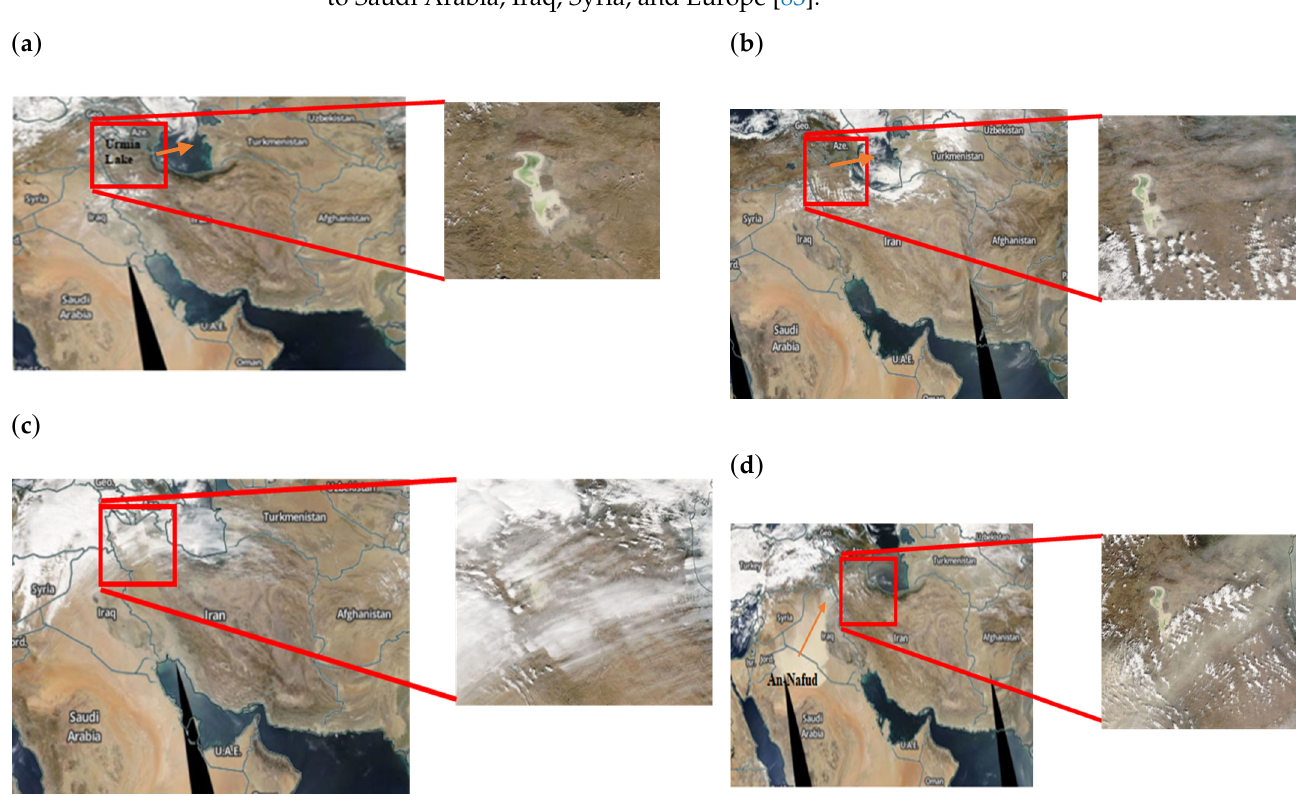
Figure 8. MODIS true-color image of Aqua on ( a ) 26 October, ( b ) 27 October, ( c ) 28 October, and ( d ) 29 October 2017. Orange arrows show dust transportation.